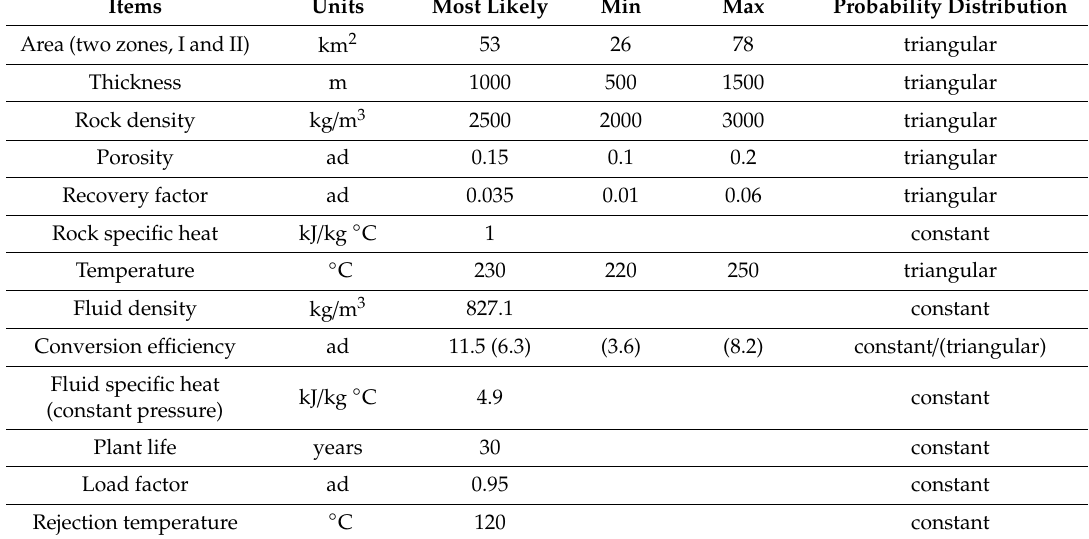
Table 2. Input parameters for the Monte Carlo simulation for the Sete Cidades site (ad = adimensional). The values for binary power plant e ffi ciency are in brackets. Reproduced with permission from [5]. Praise Worthy Prize,